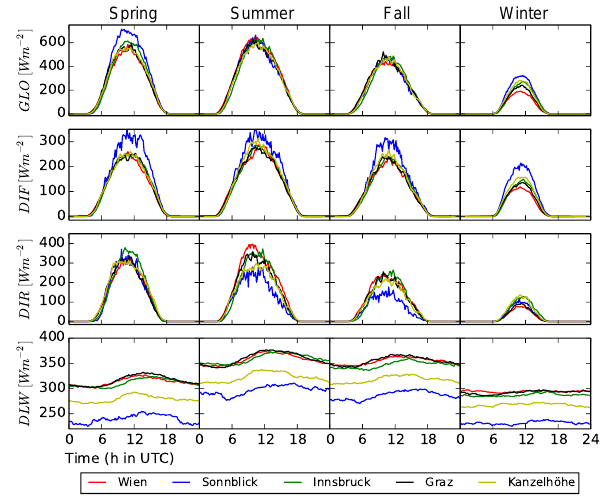
Figure 5. Seasonal mean daily courses based on 10min averages of the recorded and quality-controlled 1min average values for all measured irradiance quantities at all ARAD stations for the full an- nual cycle 1 December 2013 to 30 November 2014.